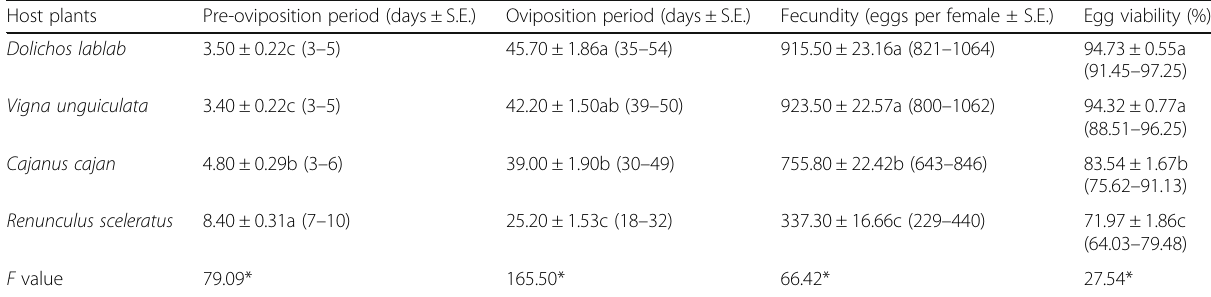
Table 1 Reproductive parameters of H. variegata when fed on aphid, A. craccivora , infested on four host plants Host plants Pre-oviposition period (days ± S.E.) Oviposition period (days ±